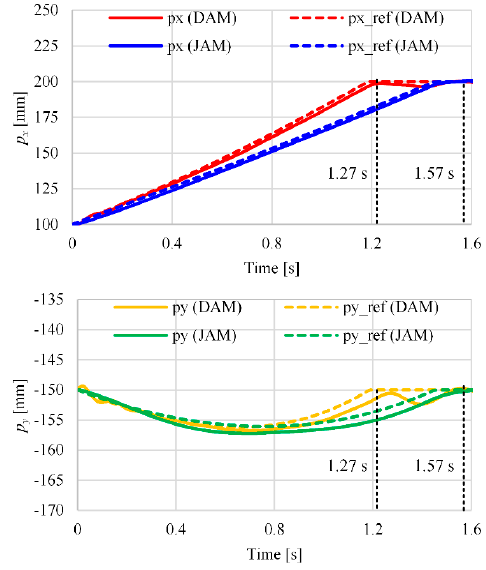
Figure 8. Time-optimal trajectory results for the end-effector reference position (dotted line) and actually controlled position through the controller (solid line).